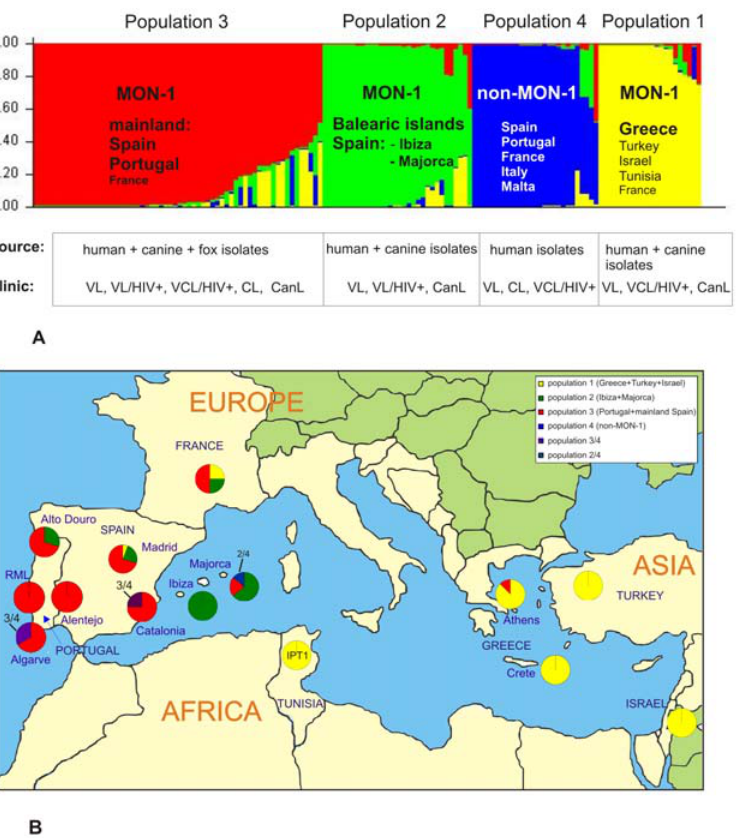
Figure 1. Population structure of Mediterranean L.infantum as inferred by STRUCTURE on the basis of data for 14 microsatellite markers obtained for 141 strains. (A) Barplot for K =4-each of the strains is represented by a single vertical line divided into K colors, where K is the number of populations assumed. Each color represents one population, and the length of the colors segment shows the strain’s estimated proportion of membership in that population. (B) Distribution of Mediterranean L. infantum MON-1 strains belonging to populations 1–3 in the respective endemic foci. Pie-charts show the proportion of each population sampled in the respective geographical region. Colors correspond to the population specific ones in Figure 1A.